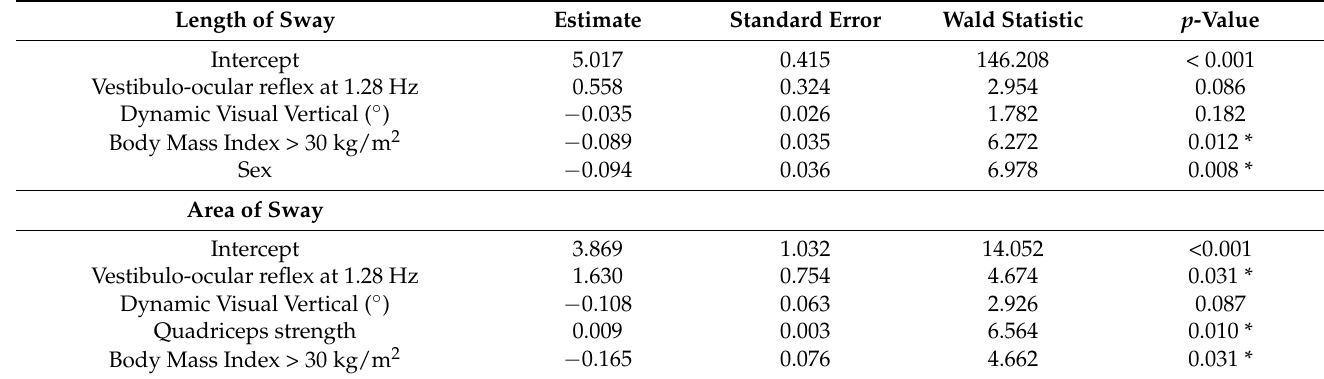
Table 3. Results of the regression analysis on postural sway while standing on hard surface with the eyes open, for the variables included in each model (* p <